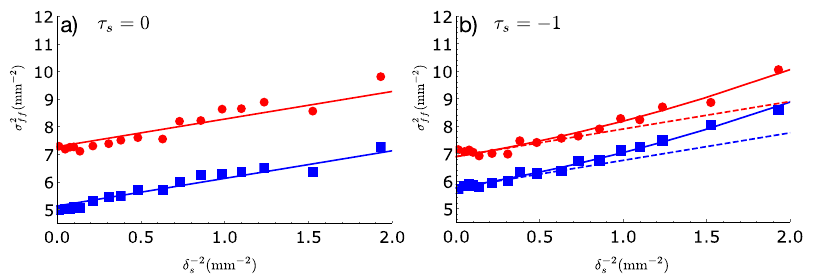
Figure 2: Transverse variance in the far-field as a function of the inverse square of the transverse coherence length (1 ∕ 𝛿 2 s ) for the seed (red circles) and idler (blue squares) beams. Error bars are smaller than the symbols. In (a) 𝜏 s = 0 and (b) 𝜏 s = − 1. The variance of the idler beam mimics the seed, showing that the transverse coherence of the idler follows that of the seed beam. The distinct y -intercepts are due to slightly different phase curvatures. See main text for additional details.